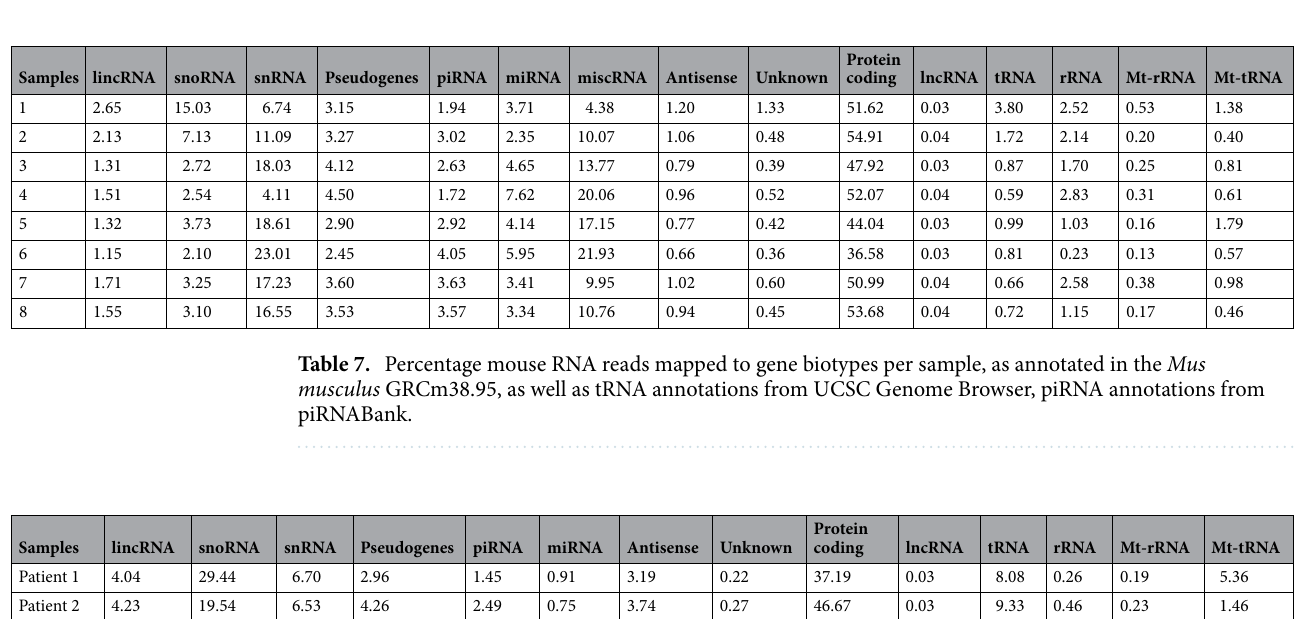
Table 6. Read alignment statistics for human-derived RNA samples.